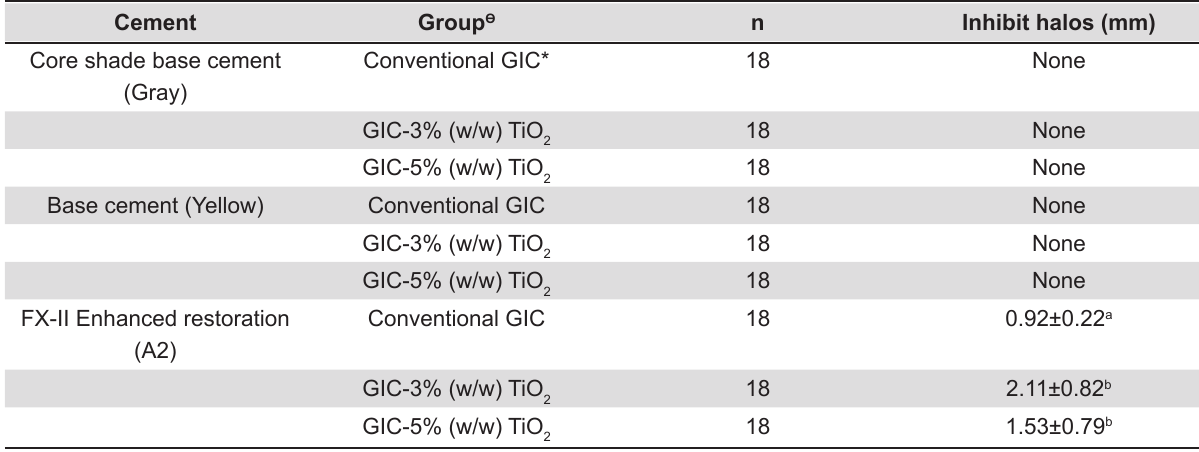
Table 2- Antibacterial activity of GIC and GIC incorporated with 3% and 5% (w/w) TiO mutans (ATCC